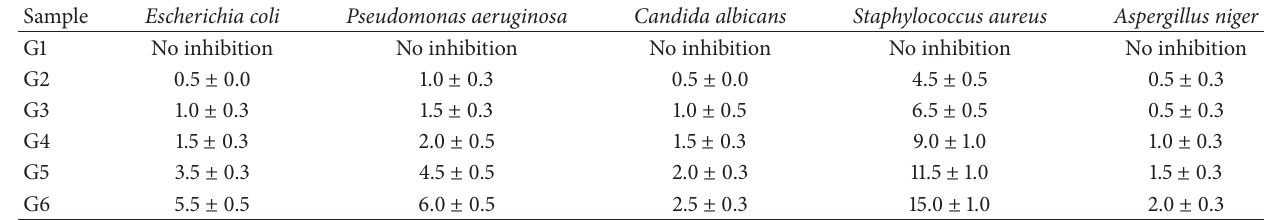
Table 3: Antimicrobial activity of freshly prepared samples G1–G6 expressed as inhibition zone diameter (mm). Sample